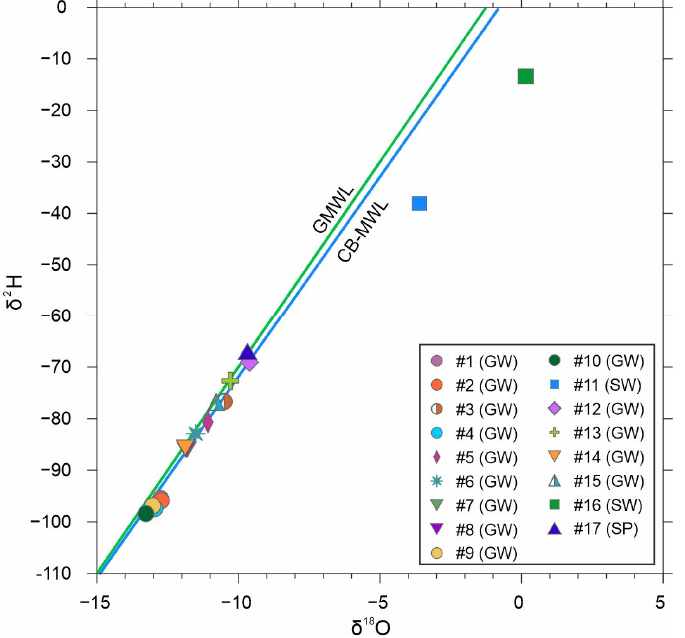
Figure 7. Stable isotopic composition of the collected water samples. GMWL: δ 2 H = 8 × δ 18 O + 10; CB-MWL: δ 2 H = 7.9 × δ 18 O + 3.9.